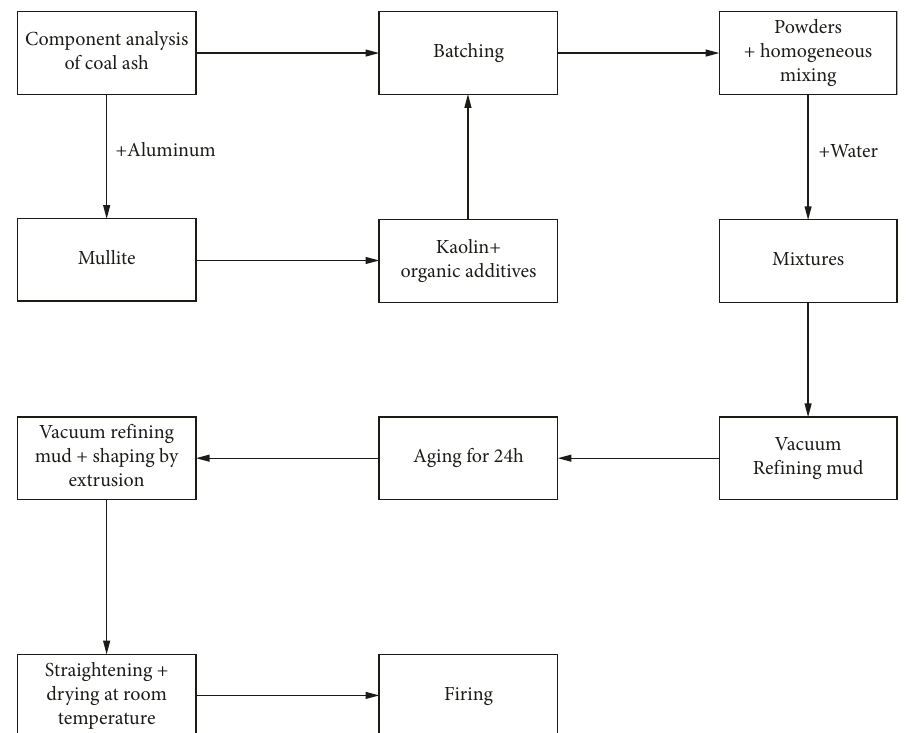
Figure 1: Flow chart for preparation of coal ash ceramic membrane.